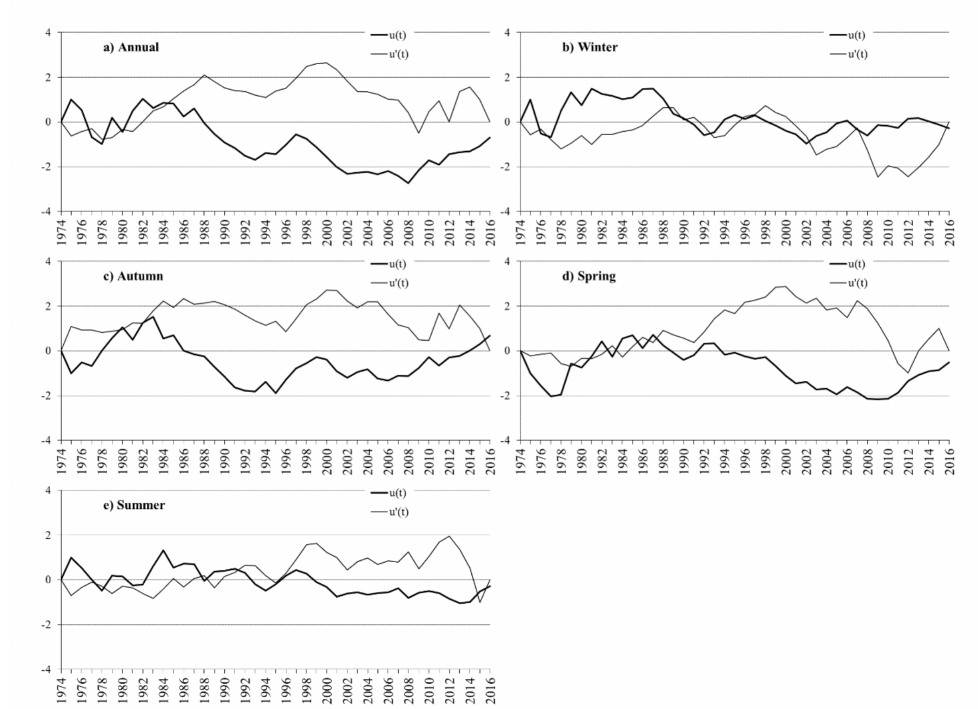
Figure 6. Graphical representation of the series u ( t ) and the retrograde series u ’( t ) of the sequential version of the Mann–Kendall test for ( a ) annual, ( b ) winter, ( c ) autumn, ( d ) spring, and ( e ) summer P/PET in the University Forest of Pertouli.